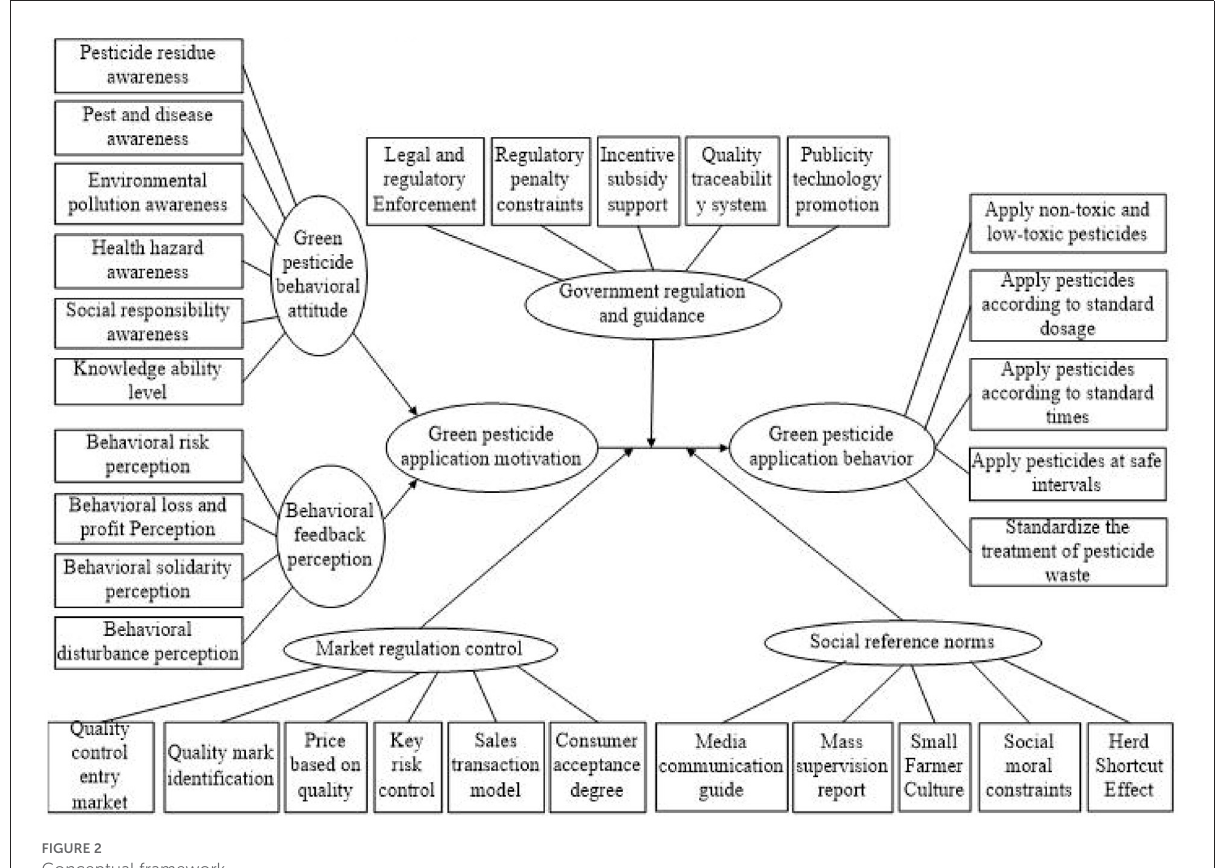
FIGURE2 Conceptual framework.